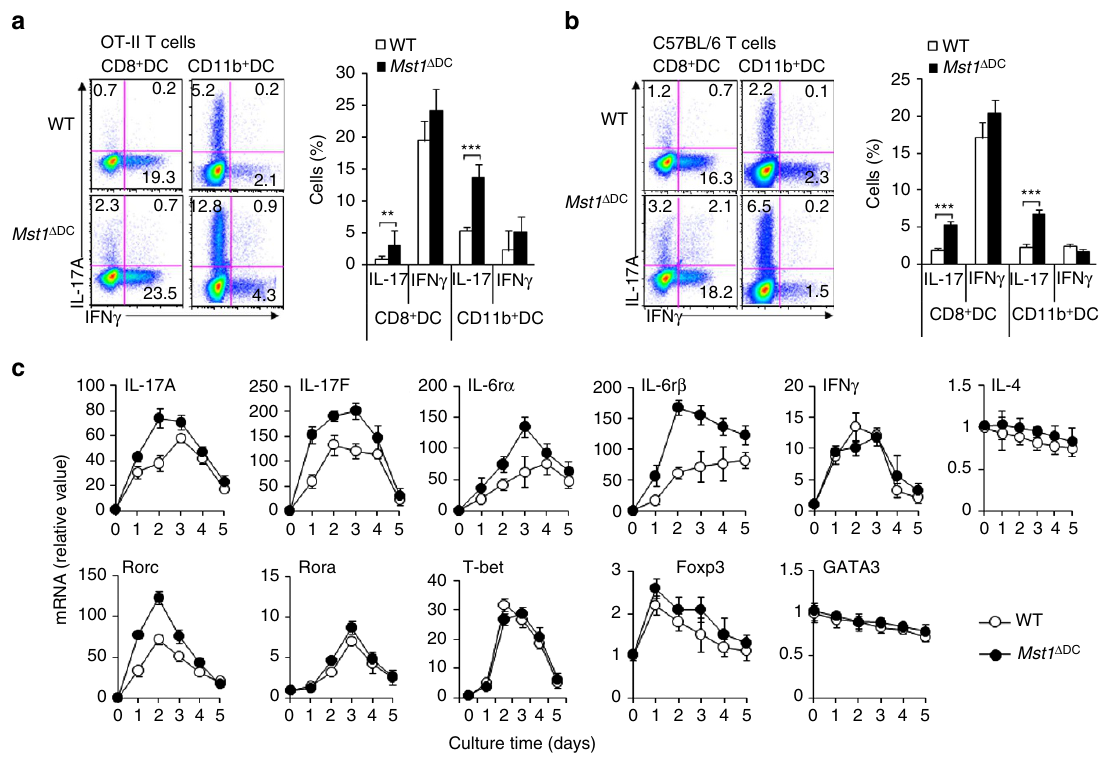
Figure 5 | DC MST1 signalling instructs Th17 differentiation in vitro . ( a ) Naive CD4 þ T cells sorted from OT-II mice stimulated with antigen and LPS-pulsed CD8 þ DCs or CD11b þ DCs from WTor Mst1 D DC mice for 5 days. Intercellular staining of IL-17 and IFN g in Tcells. Right, proportion of IL-17 and IFN g in Tcells. ( b ) Naive CD4 þ Tcells sorted from C57BL/6 mice stimulated with anti-CD3 (2 m gml (cid:2) 1 ) and LPS-pulsed CD8 þ DCs or CD11b þ DCs from WTor Mst1 D DC mice for 5 days. Intercellular staining of IL-17 and IFN g in Tcells was determined with FCM and a typical figure is shown. Right, proportion of IL-17 and IFN g in Tcells. ( c ) Naive Tcells from C57BL/6 mice were co-cultured with WTor Mst1 D DC splenic DCs for 5 days in the presence of anti-CD3 and LPS. mRNA expression of the indicated genes in Tcells were determined with qPCR. Levels in the WTcontrol groups were set to 1. Data are representative of three to four independent experiments (mean ± s.d.; n ¼ 4–6). ** P o 0.01 and *** P o 0.001, compared with the indicated groups. P -values were determined using Student’s t